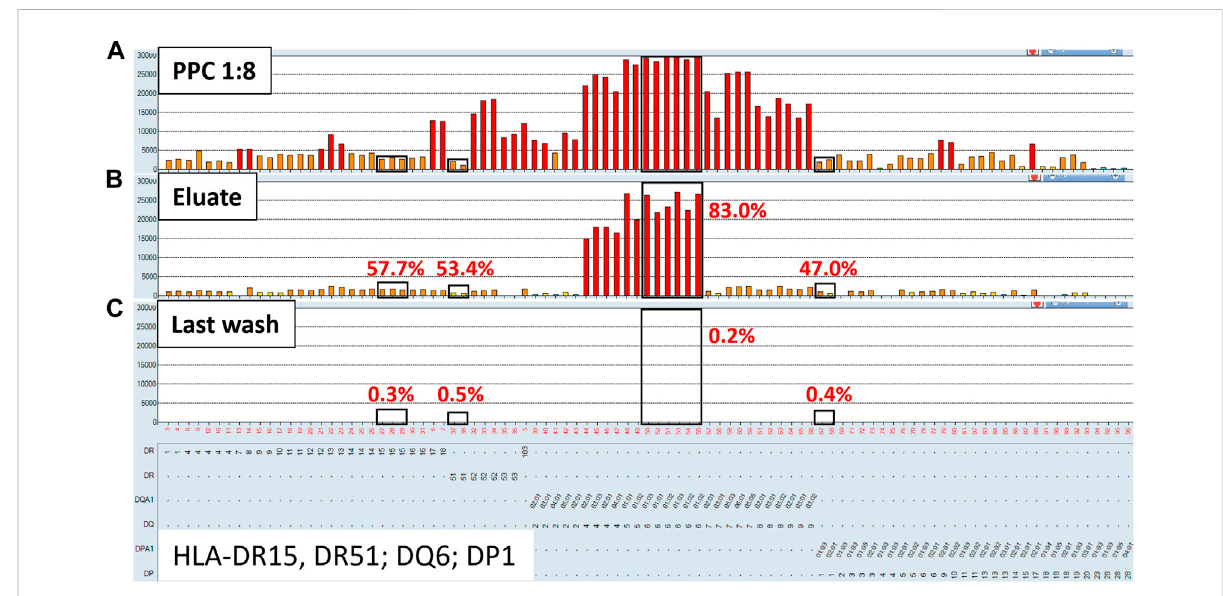
FIGURE 2 Class II HLA antibodiesare ef fi cientlyadsorbed/eluted from sera usingthe AXE protocol. Representative SABimages ofClass II HLA speci fi cities in the pooled positive control (PPC; 1:8 dilution) serum (A) , the AXE eluate (B) and the last wash control (C) are shown. Mean fl uorescence intensity (MFI) values are displayed on the Y axis. The SAB HLA speci fi cities ( X axis of panel (C) are sorted in numerical order within each HLA locus (HLA-DR, DQ and DP). Bead reactions corresponding to the AXE donor speci fi c antigens are highlighted with black rectangles and the antigens are listed atthebottomofpanel (C) .ThetopofeachblackrectanglealignswiththemaximumPPCMFIvalueinthe1:8dilutedPPCserum (A) .Theef fi ciency(% MFI compared to serum) of adsorption/elution by AXE (B) and the residual reactivity (% MFI compared to serum) in the last wash control (C) are indicated with red